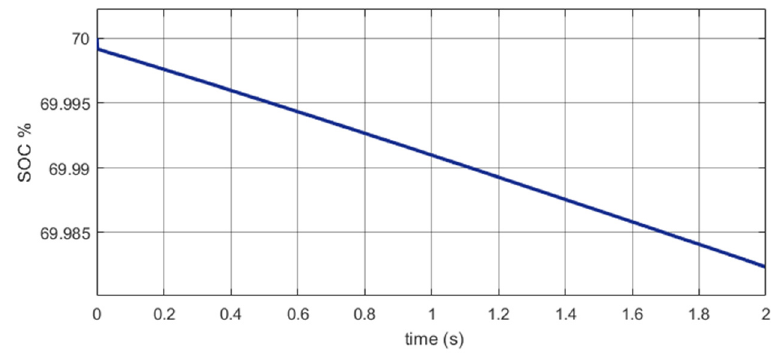
Figure 15. State of charge of the storage ba tt ery.